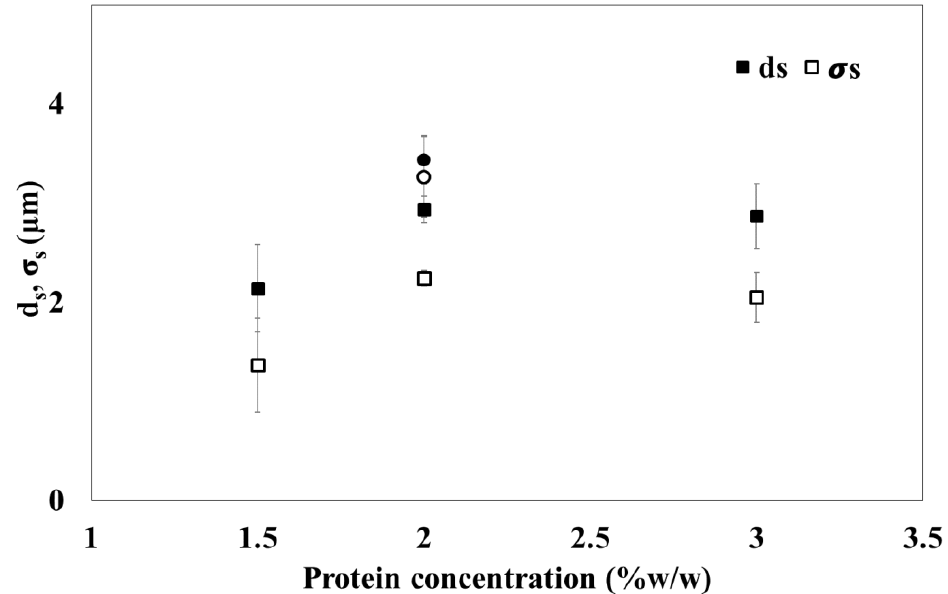
Figure 3. Average droplet diameter, d s and standard deviation, σ s , for the different O/W emulsions. The square symbol indicates samples without stabilizing while the circle symbol is for the emulsion with gellan gum (H_2_G).